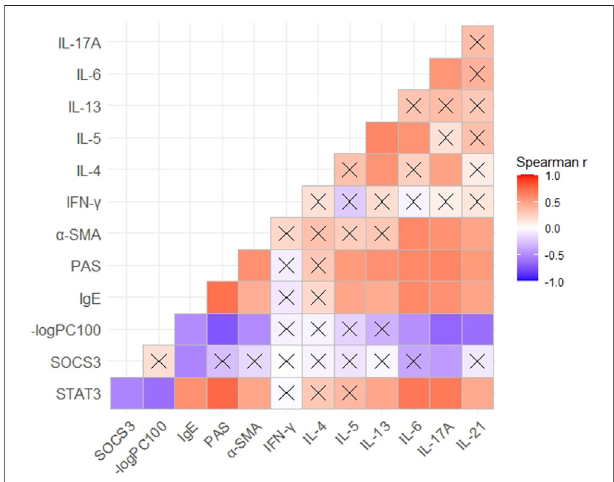
FIGURE 5 | Correlation between the expression of STAT3 or SOCS3 and mucus secretion as well as in fl ammation, responsiveness, and remodeling of the airways in different asthma models. Spearman ’ s correlation coef fi cient matrix and Spearman ’ s rank correlation tests were conducted. The expression of STAT3, SOCS3, and α -SMA was discovered from the results of immunohistochemical analyses. The expression of IgE and Th1/Th2/Th17-related cytokines was obtained using ELISAs of serum. A cross indicates no signi fi cance. p -Values are shown in Supplementary Table S1 . SOCS3, suppressor of cytokine signaling 3; STAT3, signal transducer and activator of transcription 3; α -SMA, α -smooth muscle actin.